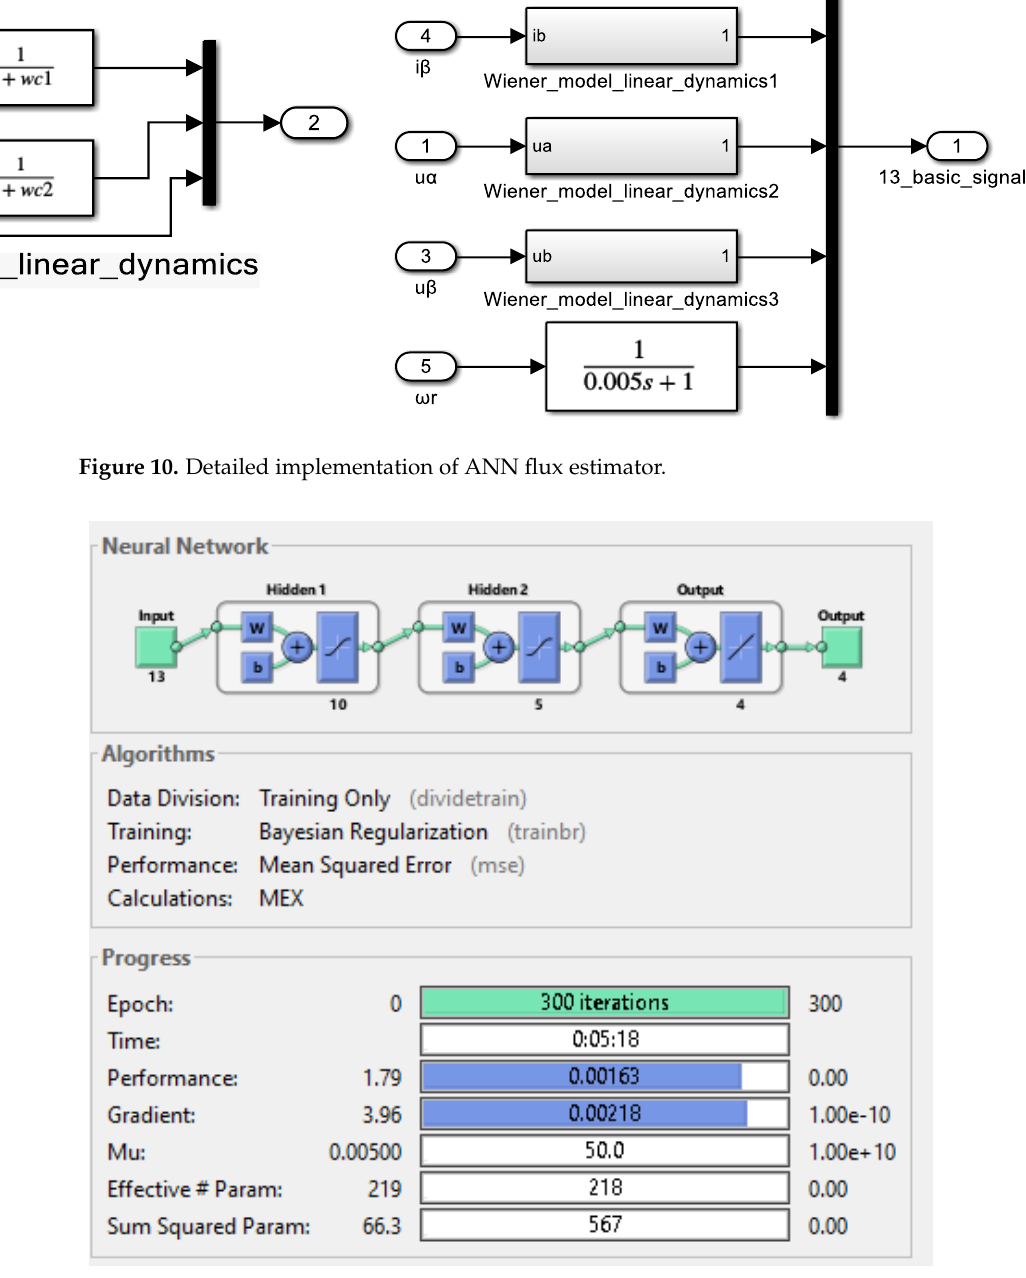
Figure 11. Simulink diagram ANN-based flux estimator.